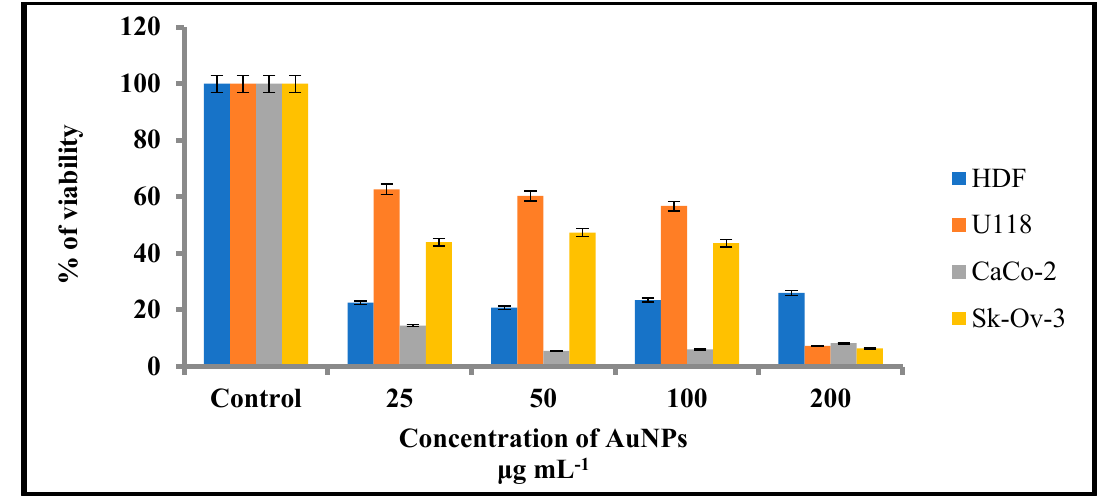
Figure 12. Cell viability rates after 48 h of interaction with AC-AuNPs applied at varying concentrations. Table 6. Comparison of the % viability-suppressing effect concentrations of some green-synthesized AuNPs on different cancer cell